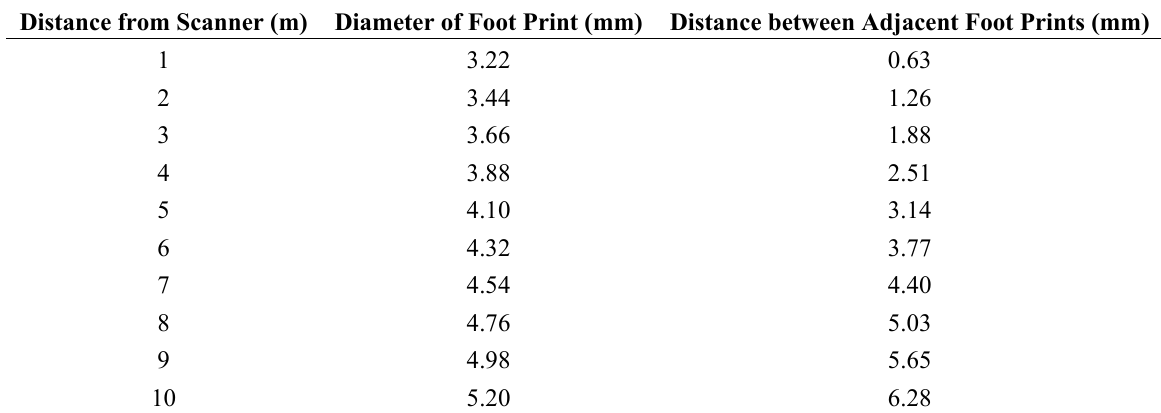
Table 3. The diameter of the foot print and the distance between adjacent foot prints *. Distance from Scanner (m)